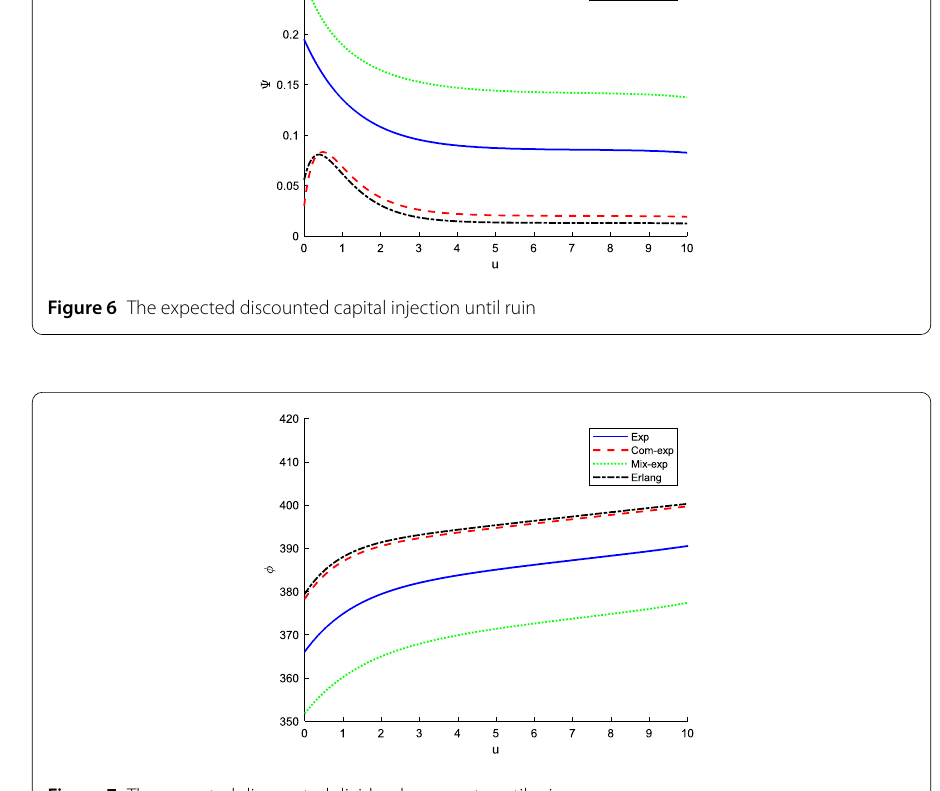
Figure 7 The expected discounted dividend payments until